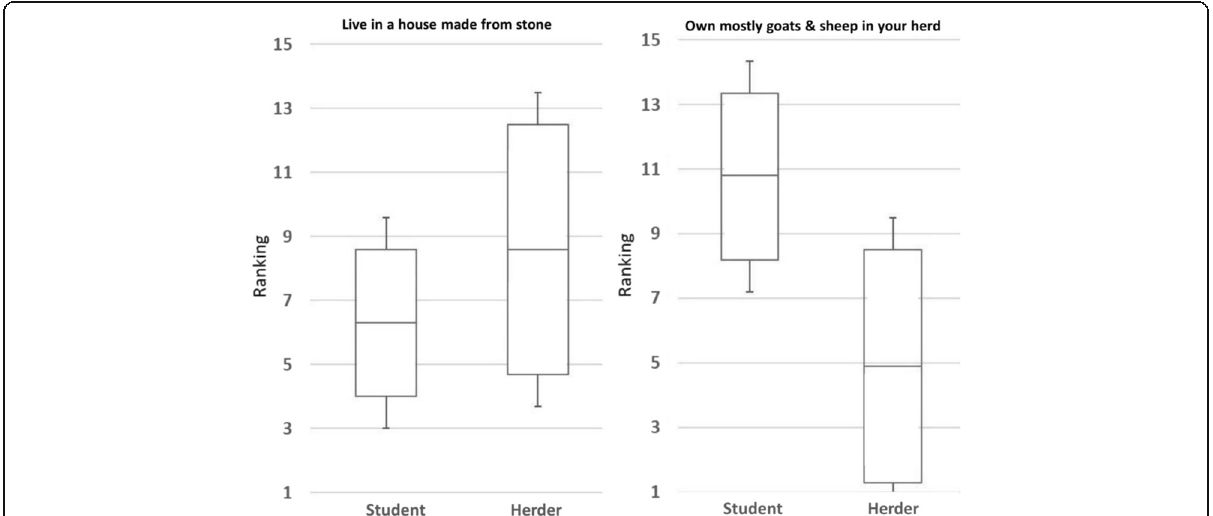
Figure 3 Boxplot of student & herder rankings on a) living in a house made of stone (contemporary), and b) owning mostly goats/sheep in your herd